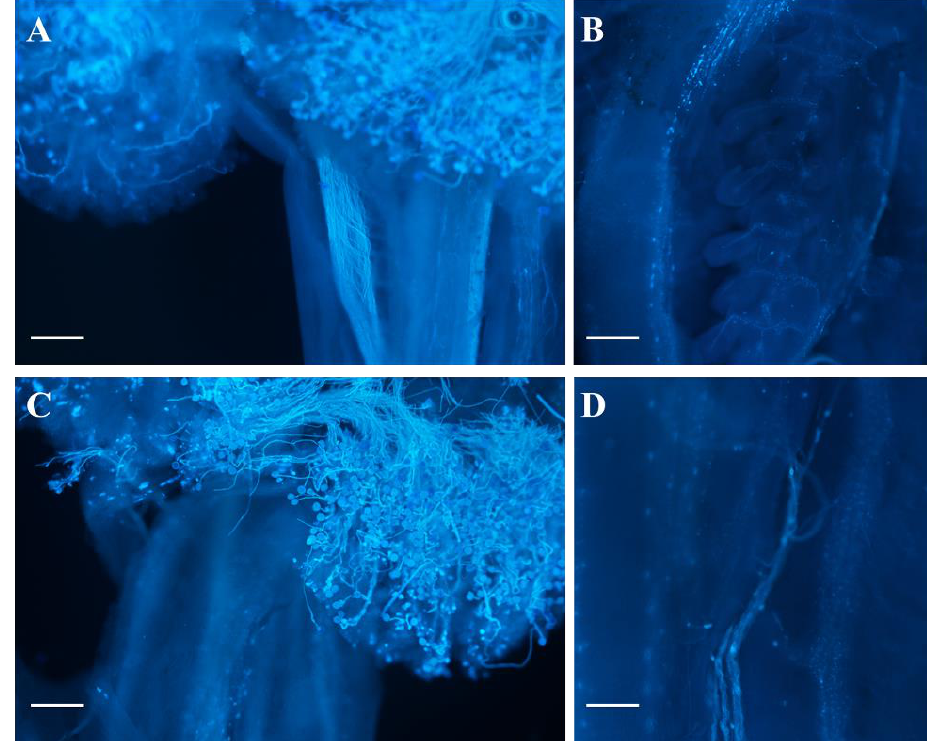
Figure 12. Fluorescence microscopic observation of pollen germination and pollen tube growth after pollination. ( A , B ) WT. ( C , D ) odd1 . Scale bars represent 200 μm.